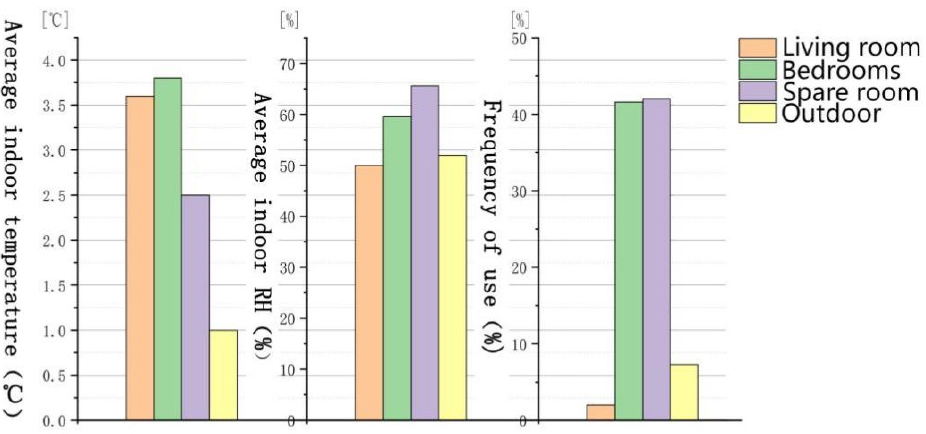
Figure 27. Room-usage frequency and indoor thermal environment.